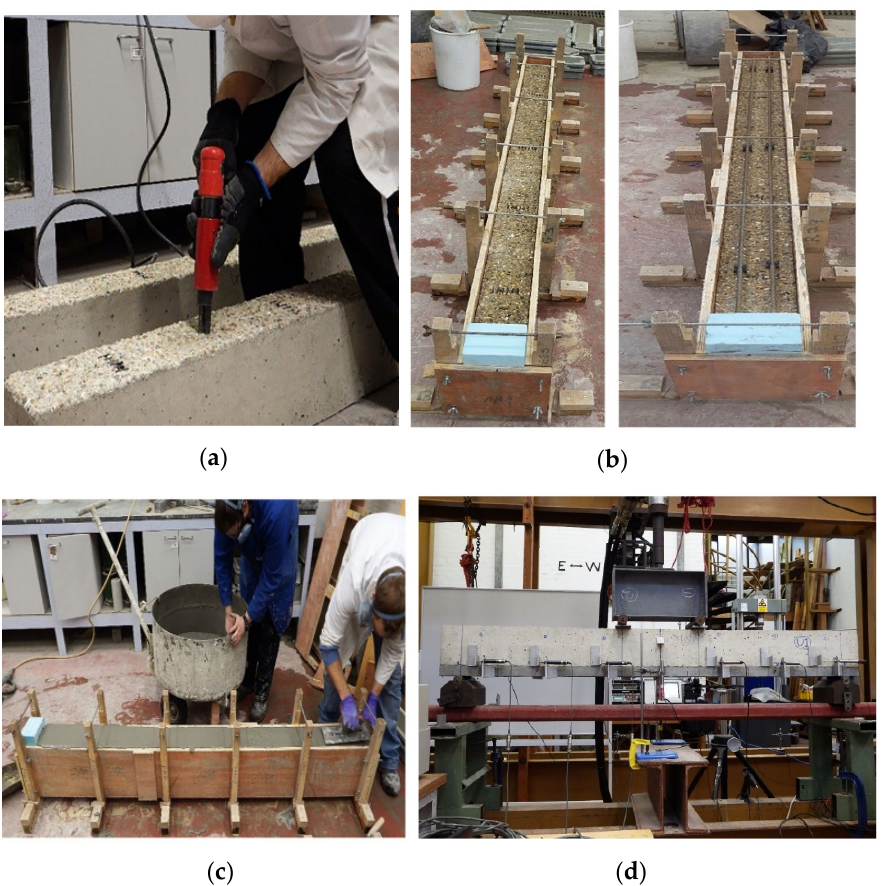
Figure 8. Flexural strengthening using UHPFRC overlays. ( a ) Surface preparation of the beams, ( b ) beams ready for casting of the layer (unreinforced and reinforced), ( c ) casting the UHPFRC